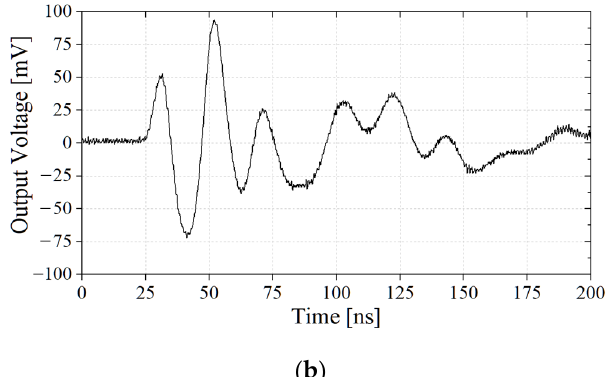
Figure 4. The output of UHF sensor: ( a ) calibration result and ( b ) output waveform.